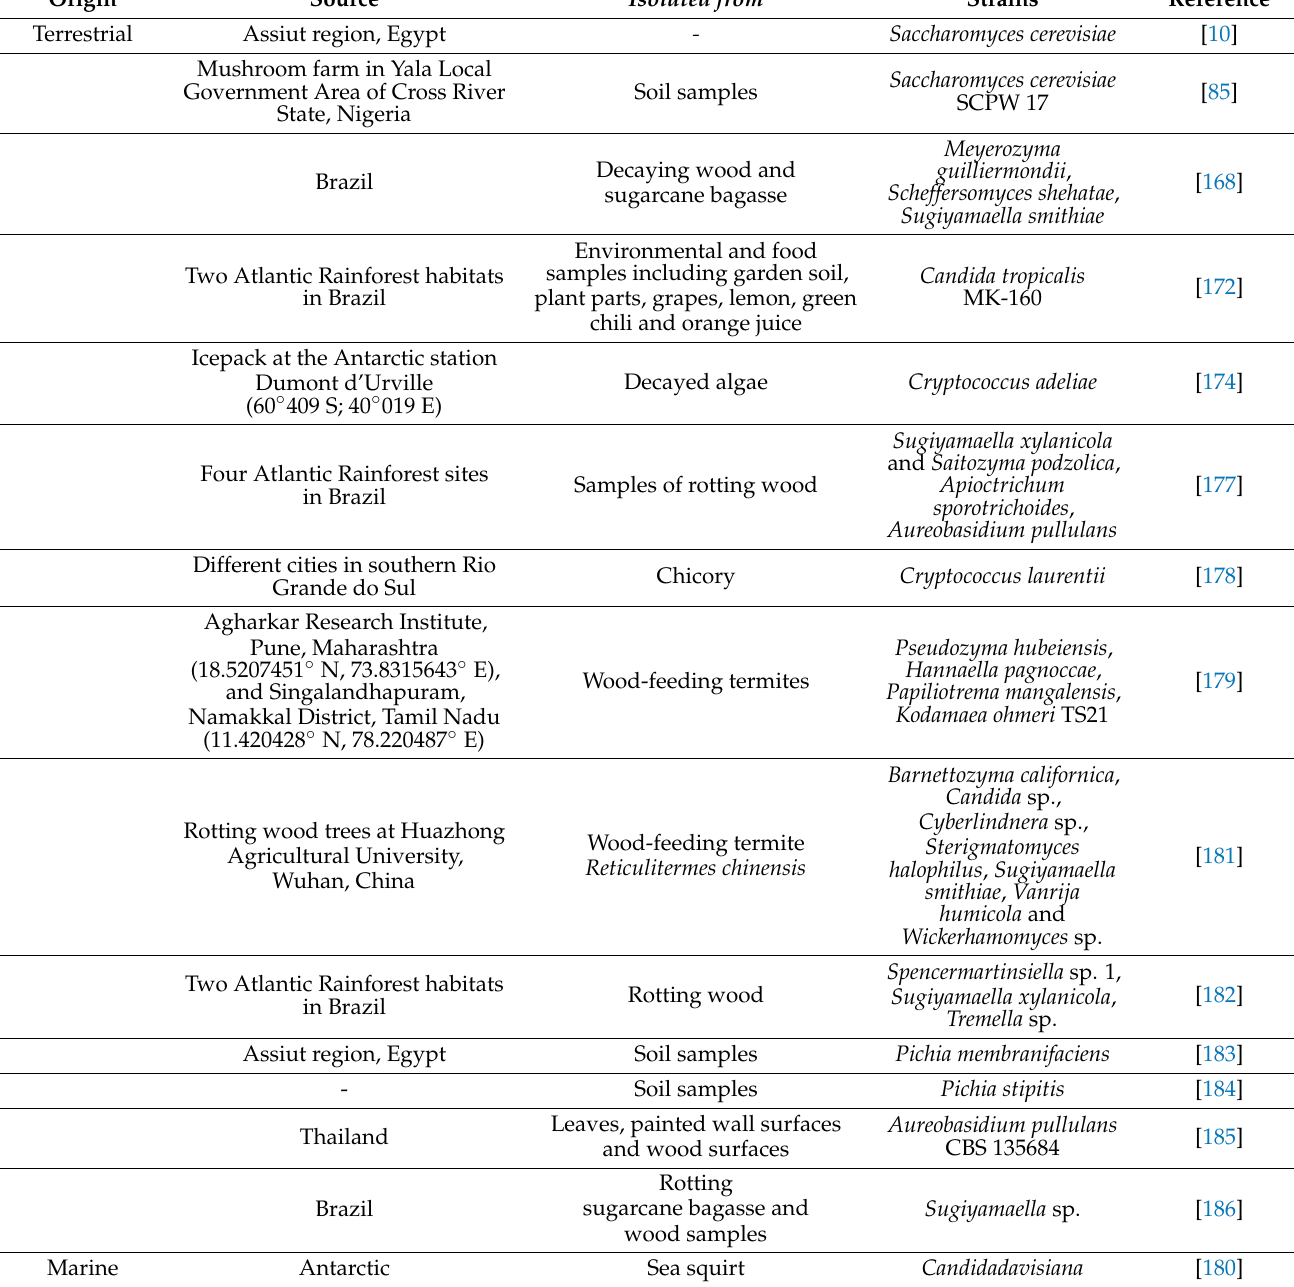
Table 4. Examples of reported xylanolytic